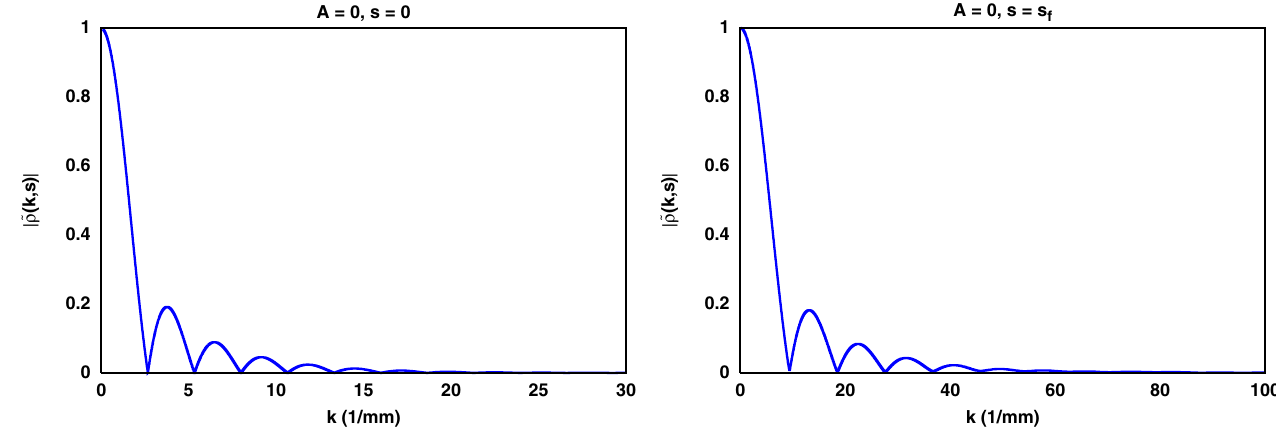
FIG. 6. (Color) Fourier spectra without perturbation ( " ¼ 0 ). Left: at s ¼ 0 ; right: at s ¼ s